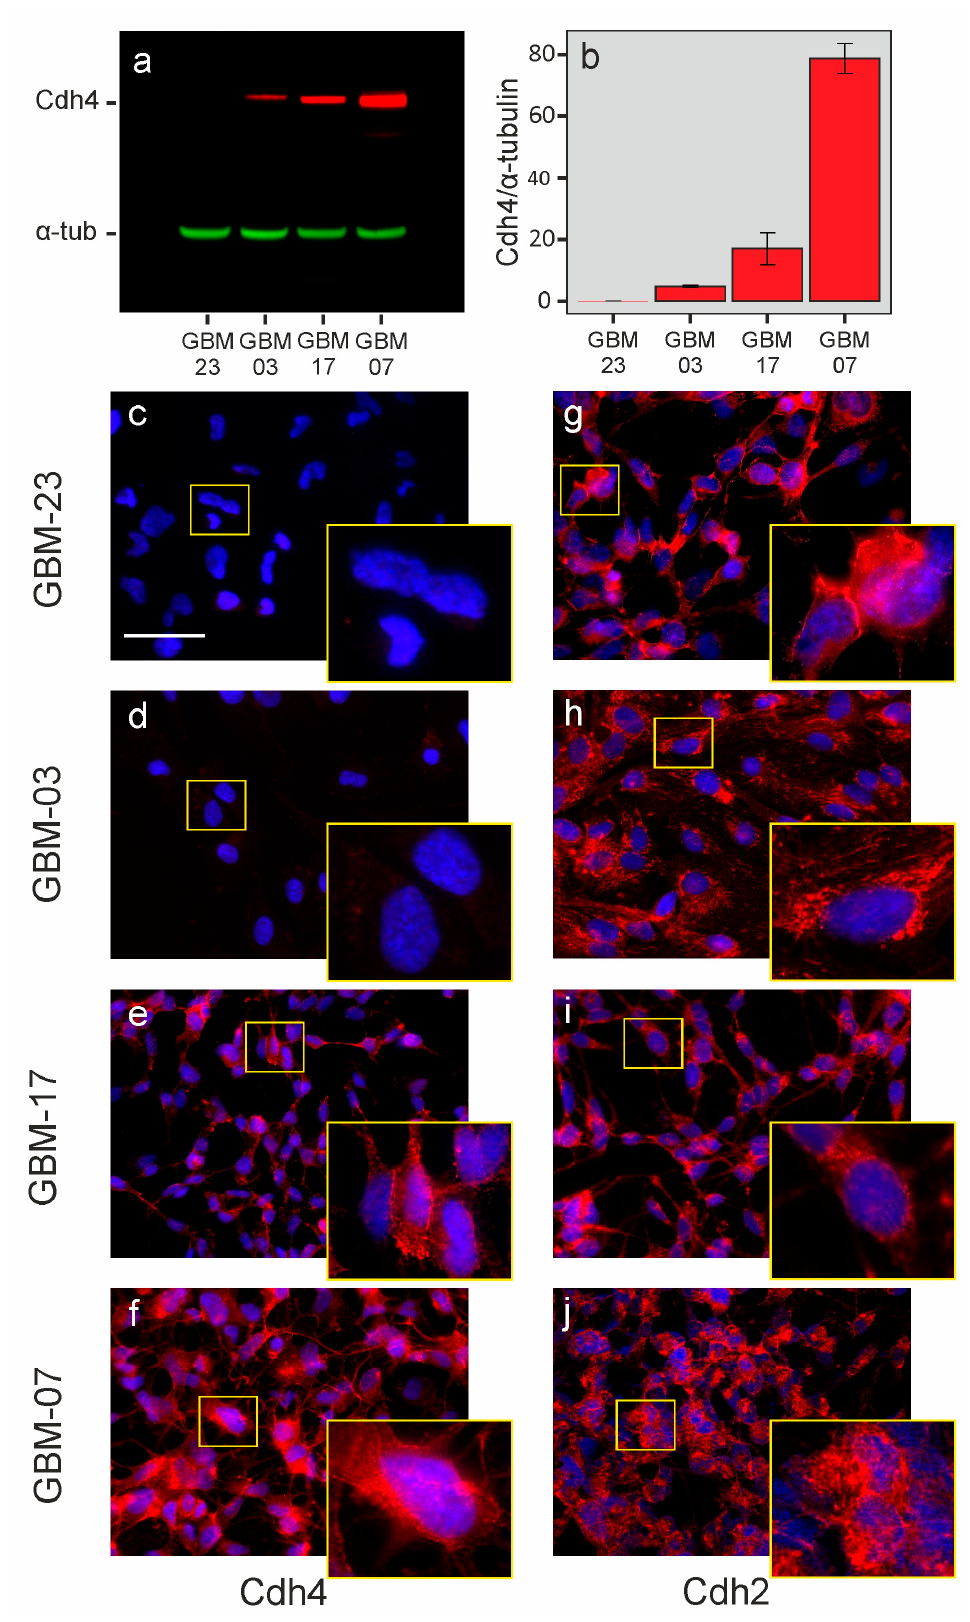
Figure 2. ( a , b ) Quantification of Cdh4 protein expression by Western blot of di ff erent GIC cultures. ( c – j ) Representative immunofluorescence stainings of di ff erent human GIC cultures with anti-Cdh4 ( c – f ) and anti-Cdh2 ( g – j ) antibodies in red and Hoechst for nuclei staining in blue. Scale bar: 50 µ